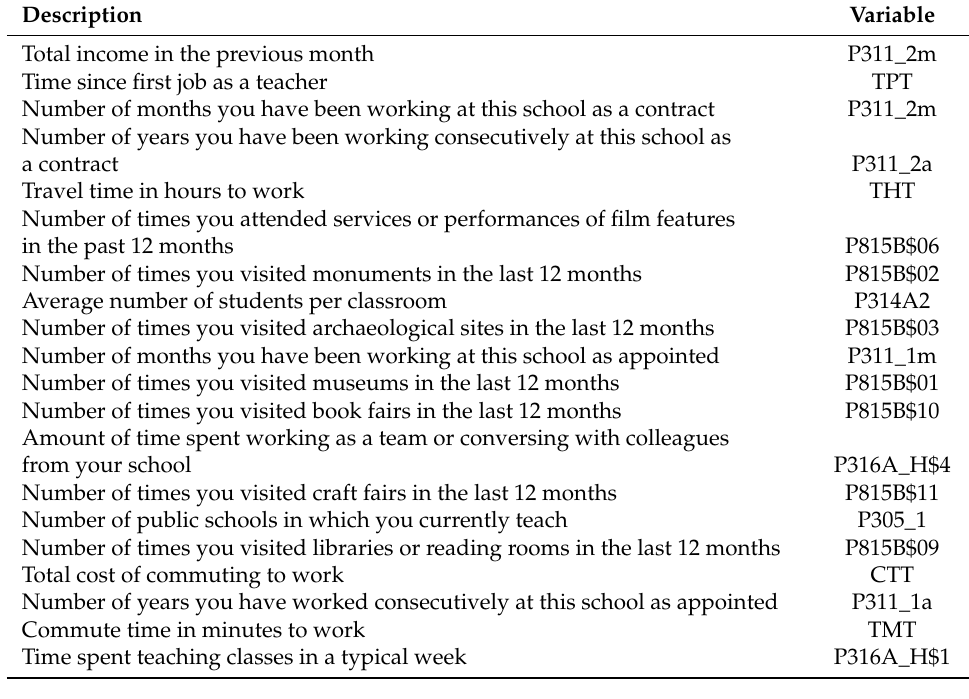
Table A1. Data dictionary of the features selected with the ANOVA F-test filter.